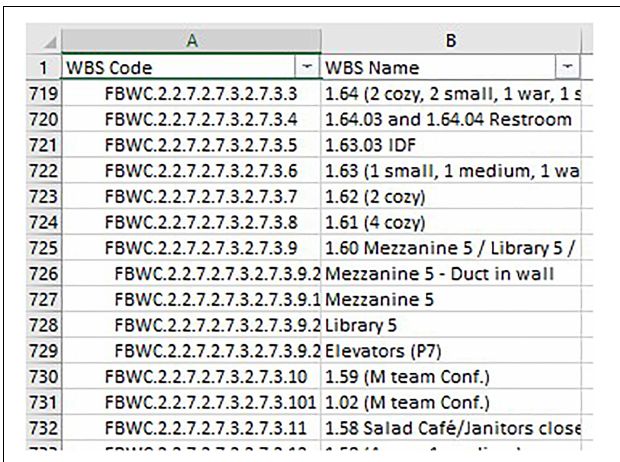
FIGURE 4 | Sample of a WBScode spreadsheet exported from P6.